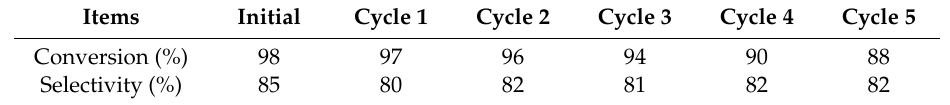
Table 3. Reusability of H β -3 in benzylation of p